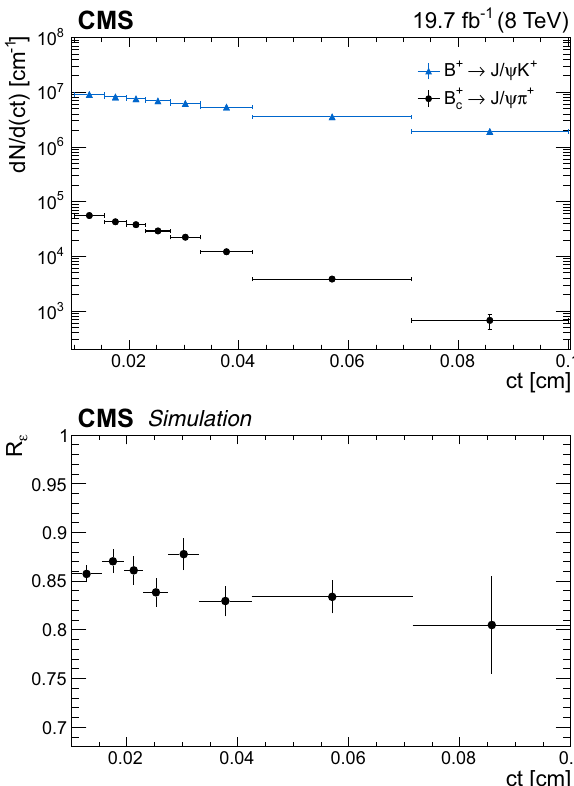
Fig. 5 The J /ψπ + invariant mass distribution (left) with the solid line representing the total fit, the dashed line the signal component, the dot- ted line the combinatorial background, and the dashed-dotted line the contributionfromB + c → J /ψ K + decays.TheJ /ψ K + invariantmassdis- tribution (right) with the solid line representing the total fit, the dashed line the signal component, the dotted-dashed curves the B + → J /ψπ + and B 0 contributions, and the dotted curve the combinatorial back- ground. The vertical bars on the data points represent the statistical uncertainties